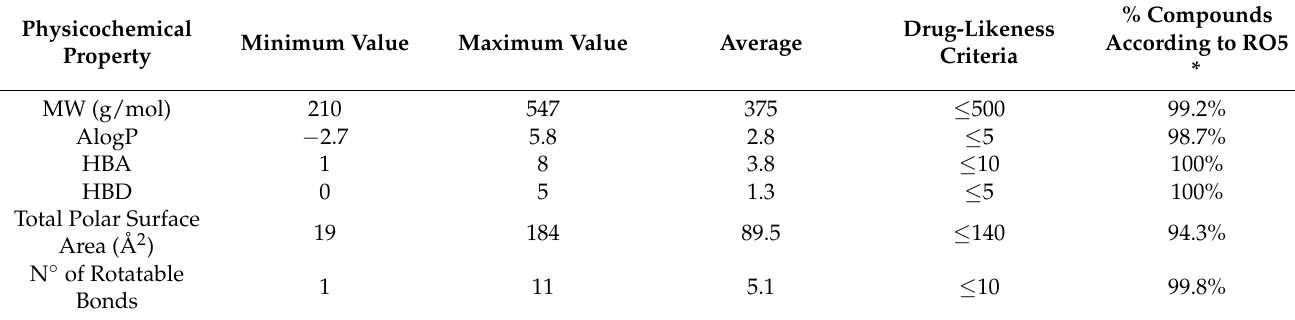
Table 1. Drug-likeness properties of the Kinetobox compound